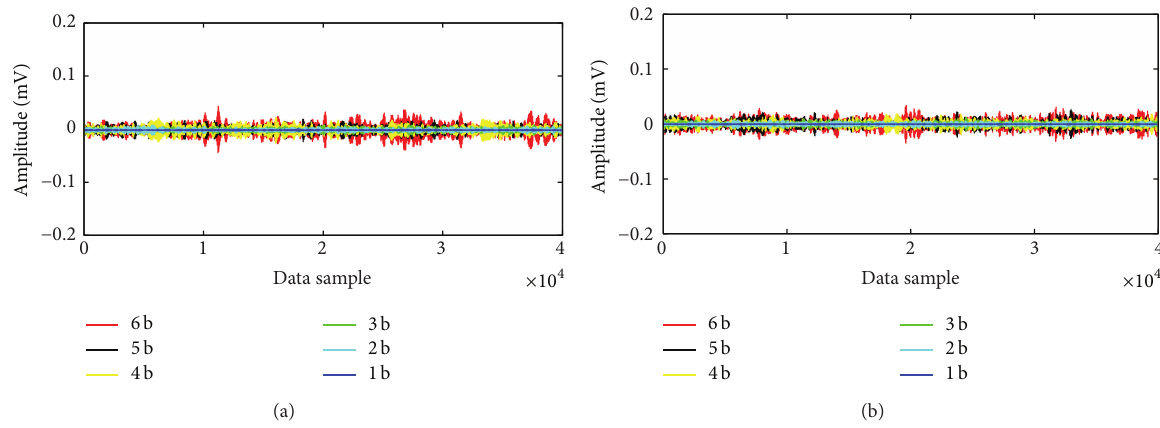
Figure 9: Raw AE signal due to leakage through lifted valve in cylinder 4. (a) 0.1 mm lifted exhaust valve and (b) 0.1mm lifted intake valve.